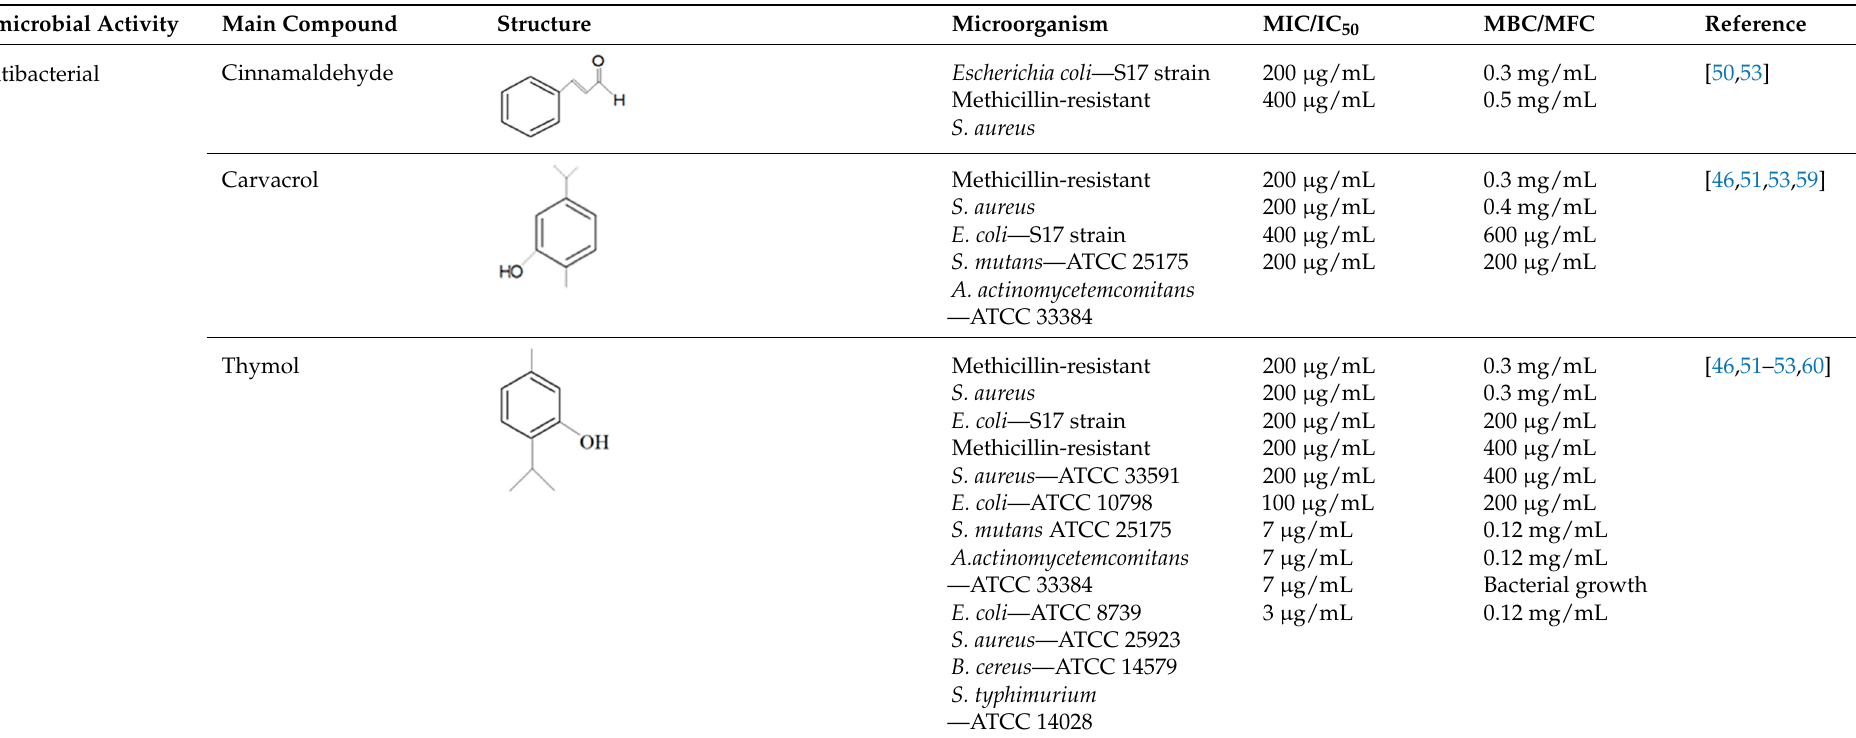
Table 2. Antimicrobial activity of individual compounds from EO against different microorganisms.